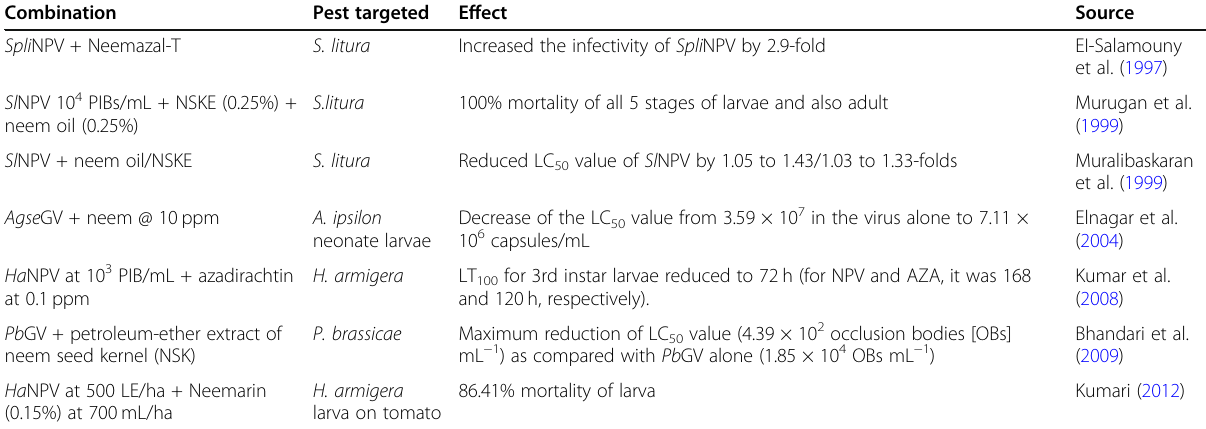
Table 3 Synergism of insect virus and in combination with botanicals Combination Pest targeted